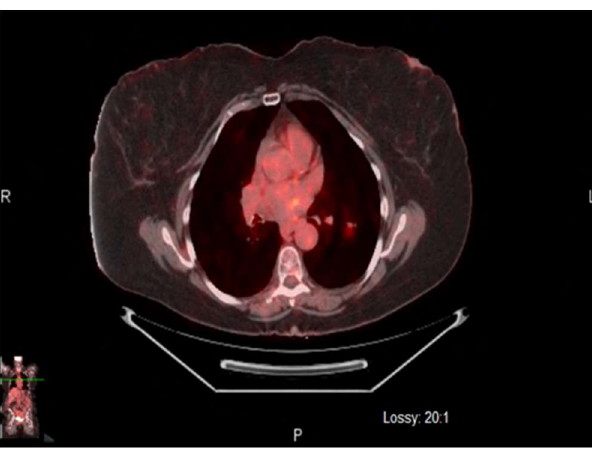
Figure 4. PET Image Showing Fluorodeoxyglucose Uptake in Superior Segment of Left Lower Lobe.